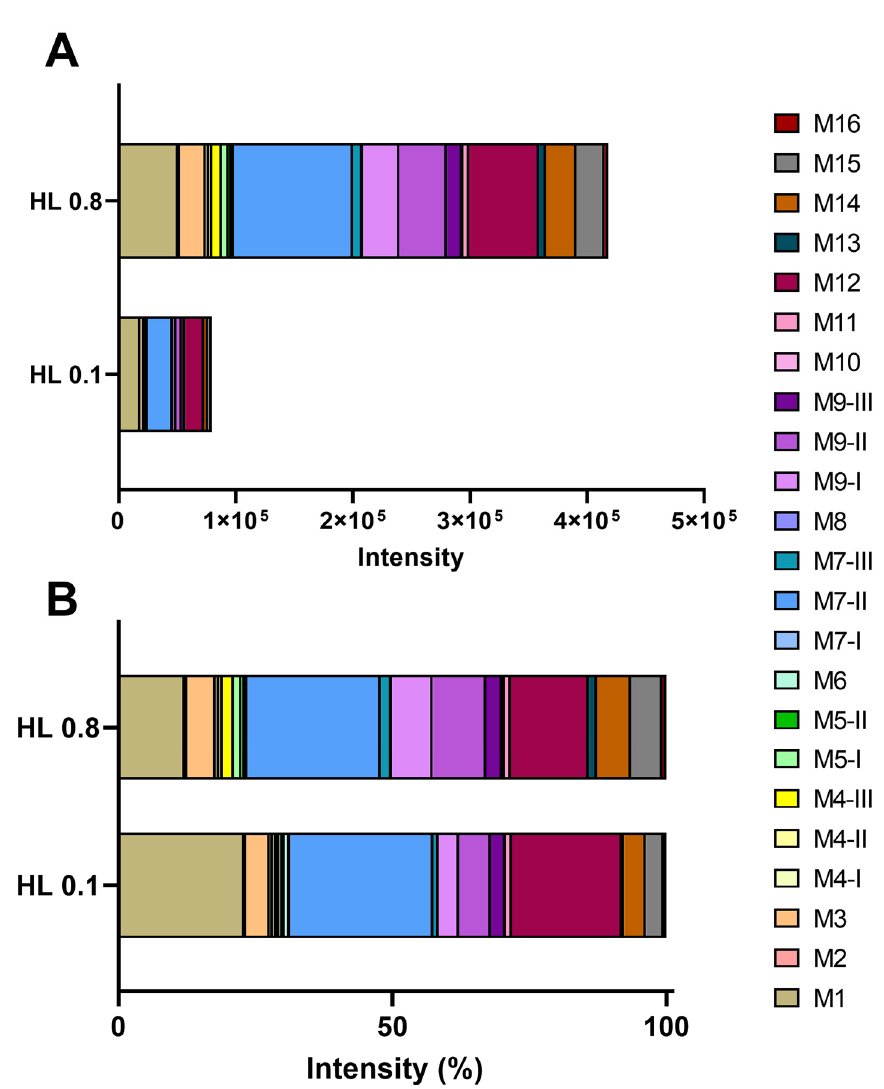
Figure 4. ( A ). Diversity of metabolites expressed in intensity of the chromatographic peak normal- ized by creatinine excretion detected in relation to the total metabolites excreted. ( B ). Diversity of metabolites expressed in percent in relation to the total metabolites excreted.